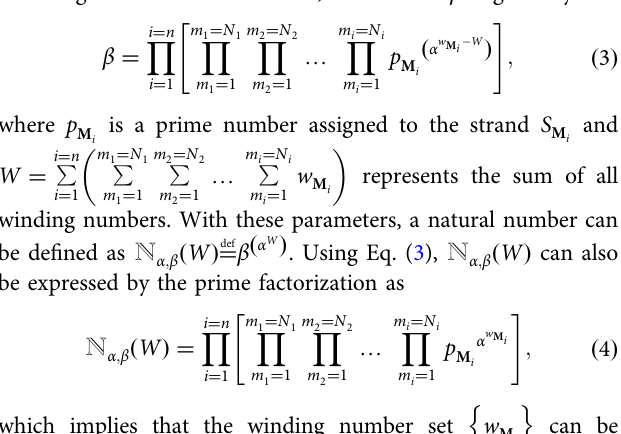
Fig. 1 Theoretical construction of nested vortex knots and links. a A nested three-strand braid twisted three times in the ð x 0 ; y 0 ; h Þ coordinate system, represented by Eq. (1) with N i ¼ 3, w M ¼ 1. b Starting end plane of the nested three-strand braid in a . The centers of three circles with radius r 2 are on the i arc of a circle with radius r 1 . Similarly, the centers of three circles with radius r 3 are on the arc of circles with radius r 2 . The position of each circle is related to its initial rotation angle. The initial rotation angles of three circles with radius r 2 ( r 4 ) are marked with φ c Nested link arising from the braid in a by using stereographic projection, which connects the x 0 ; y 0 ; h ð Þ and ð x ; y ; z Þ coordinates system. d , e The nested vortex link degenerated from the one shown in a , c , when we consider two generations and set the number of strands N 1 ¼ 3 and N 2 ¼ 2. f , g The nested vortex link degenerated from the one shown in a , c , when we consider only one generation and set N 1 ¼ 3. The link shown in g contains three rings in the Hopf fi bration and is marked as 6 3 in Rolfsen ’ s 3